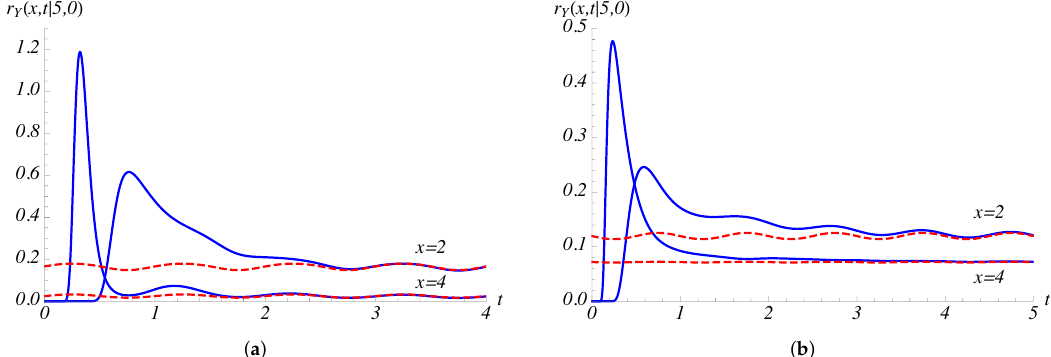
Figure 10. The transition densities, given in (46), are plotted as function of t for the same choices as Figure 6 with x 0 = 5, for x = 2 and x = 4 (solid blue curves). The dashed curves indicate the corresponding asymptotic densities. ( a ) σ 2 ( t ) = 0.2